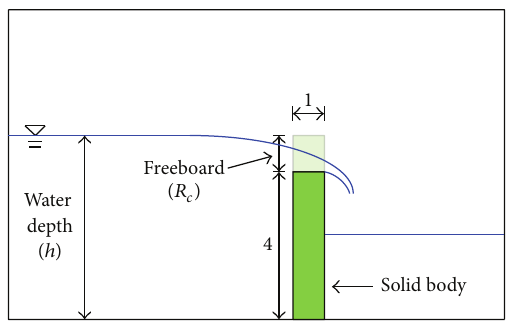
Figure 1: Sketch of the overflow at a vertical seawall.